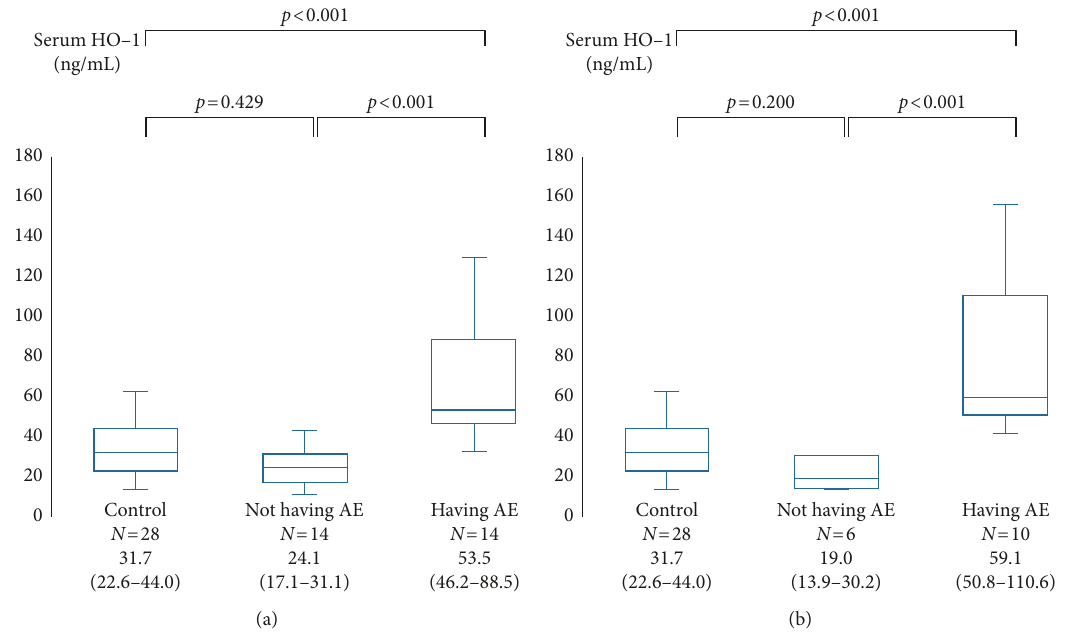
Figure 1: Serum hemeoxygenase-1 (HO-1) levels in interstitial pneumonia (IP) patients and control subjects. The HO-1 levels in IP patients having an acute exacerbation (AE) were significantly higher than those in IP patients not having an AE and those in control subjects (a). Also, the HO-1 levels in patients with IPF were significantly higher than those in patients not having an AE and those in control subjects (b). The center bold line is the median value; the bottom and top of the boxes represent the 25 th to 75 th percentiles, respectively; and the whiskers are 95% confidence